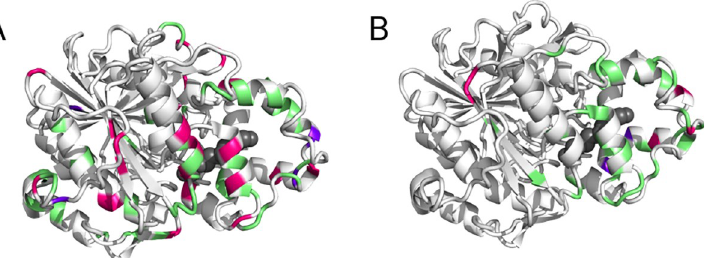
Fig 4. Residues substituted in variants conferring discriminative activity. A) Library Random 2. B: Libraries Random Tot and Random Rec, combined. Green: clear discrimination for hydrolysis of short-chain triglycerides (tributyrin). Magenta: clear discrimination for hydrolysis of the long-chain triglycerides (olive oil). Purple: residues substituted in distinct variants showing opposite discriminative phenotypes. A PEG-4 molecule is shown in black spheres, crystallized inside the putative tunnel [22,